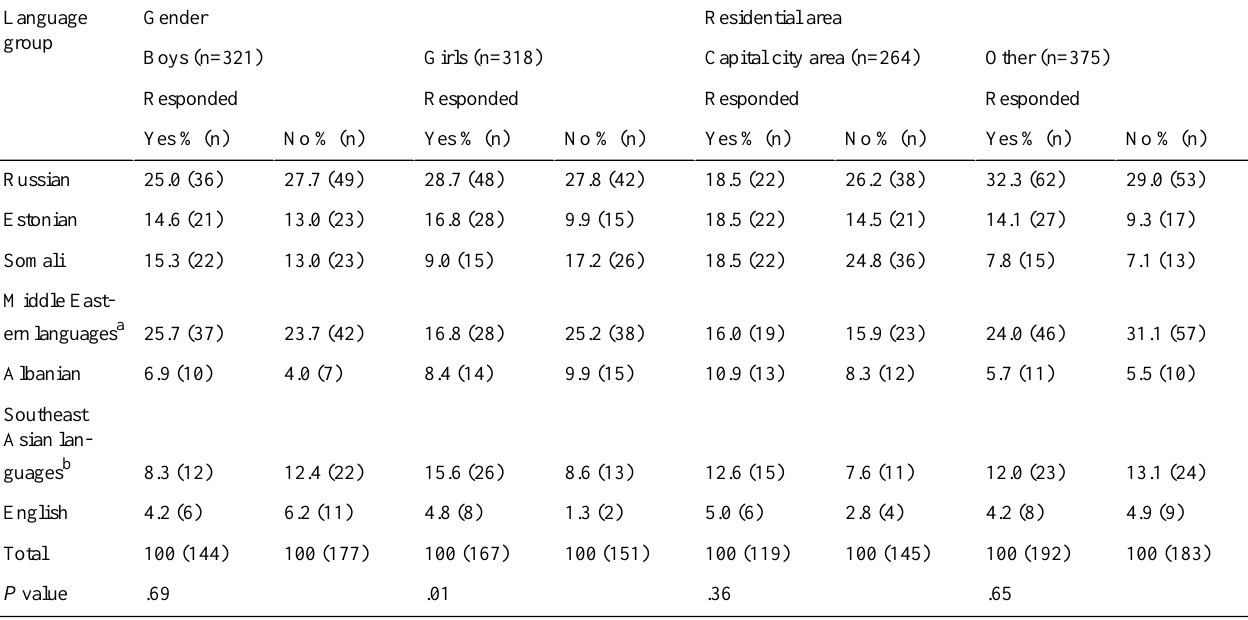
Table 2. Distribution of language groups among respondents and nonrespondents according to gender and residential area, % (n), and P value for differences between respondents and nonrespondents.